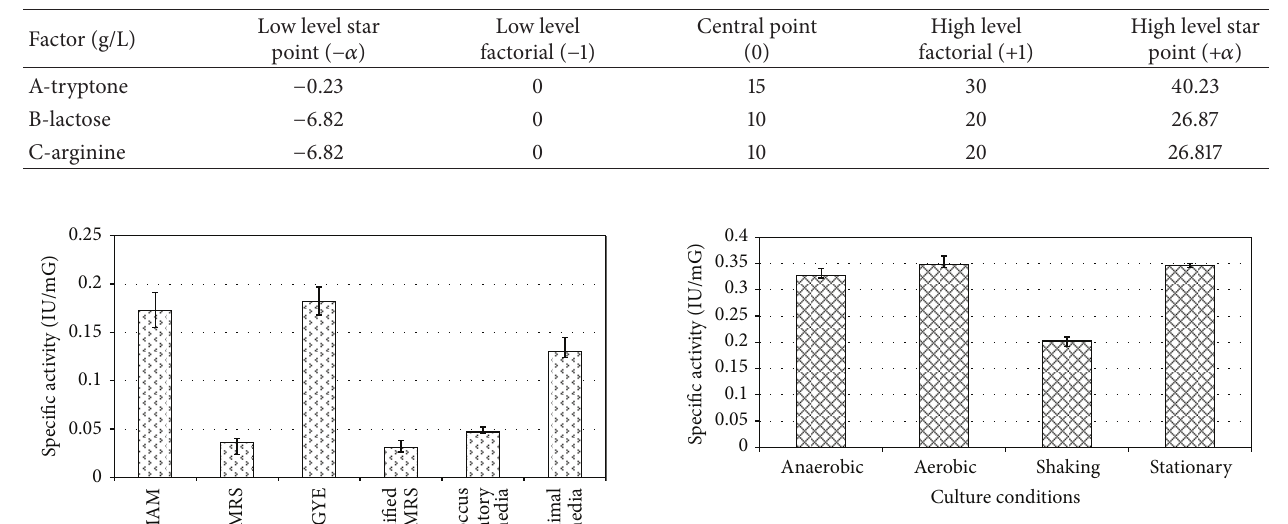
Figure 5: Effect of culture conditions on enzyme production. Results are expressed as the mean ± S.D ( 𝑛 = 3 ), 𝑃 value < 0.05.